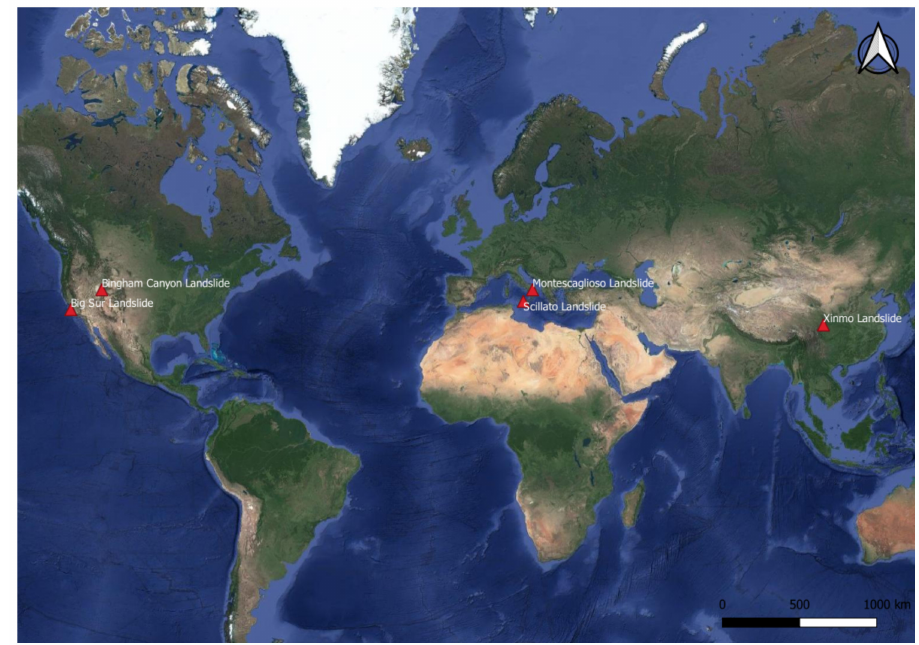
Figure 1. Landslide